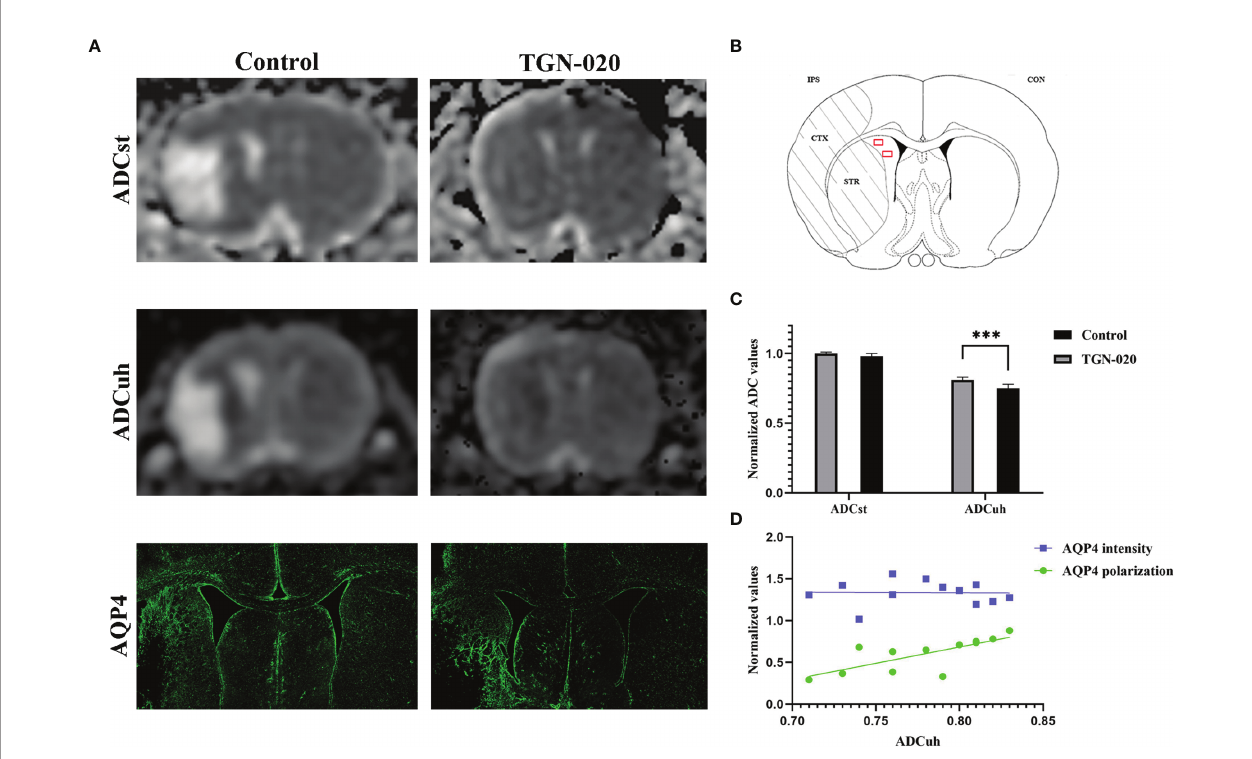
FIGURE 4 | Correspondence between ADC and AQP4 expression patterns. (A) Representative ADCst and ADCuh maps, and AQP4 staining patterns in TGN-020- treated and control rats. (B) Anatomical reference showing the ROIs (red boxes) used to estimate the ADCuh in the peri-infarct striatum. (C) Comparison of ADCuh in the peri-infarct striatum between the two groups. (D) Correlations between the peri-infarct AQP4 expression patterns and ADCuh. ***P < 0.001. Con, contralateral; CTX, cortex; IPS, ipsilateral; STR,